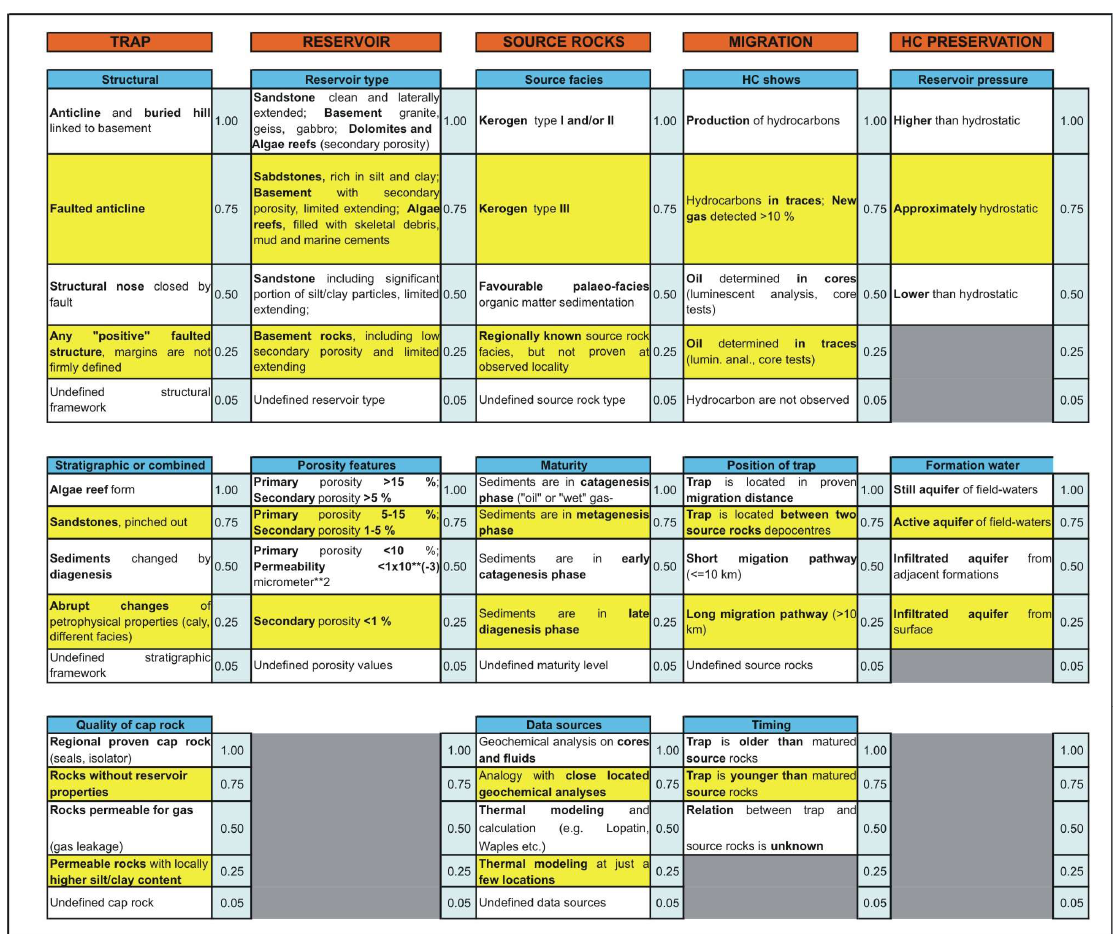
Figure 1. Geological categories and subcategories of probability of success (PoS) (e.g., [4]).